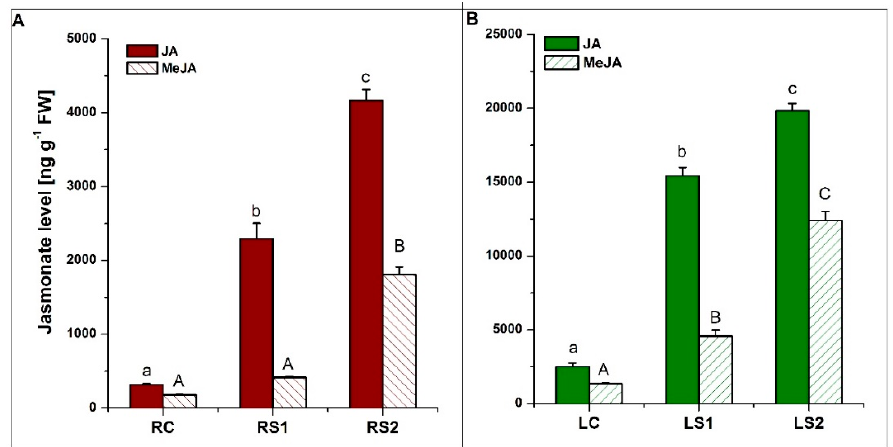
Figure 6. Quantitative analysis of jasmonic acid (JA) and methyl jasmonate (MeJA) levels in fine absorptive roots ( A ) and leaves ( B ) during senescence. Means designated by different letters indicate statistically significant differences according to ANOVA and Tukey’s post hoc test ( p < 0.05). Values represent the mean ± SE (standard error).